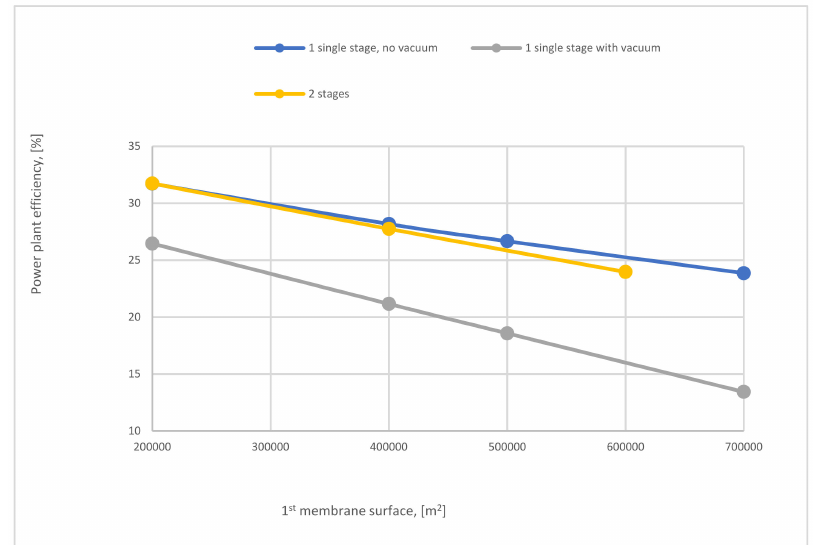
Figure 25. The impact of 1st membrane surface on power plant efficiency of 1 and 2-stages of membrane at 8 bar CP 1 , 4 bar CP 2 , and 40,000 m 2 of SA 2 .